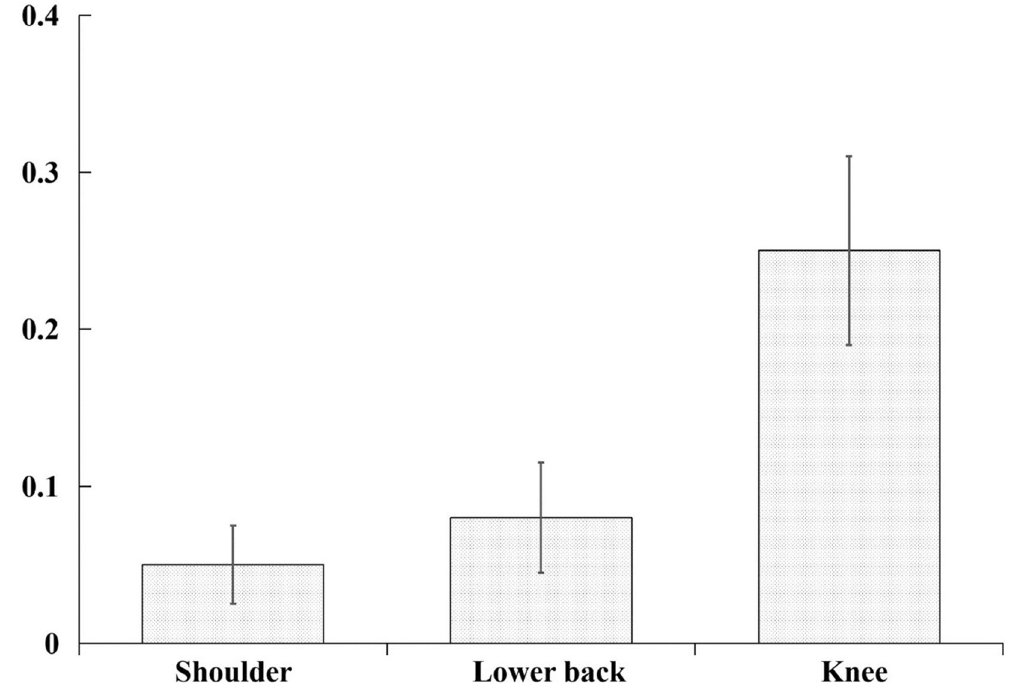
Figure 2. Injury rate per 1000 athlete-hours of exposure in shoulder, lower back and knee. The error bars represent a 95% confidence interval from the